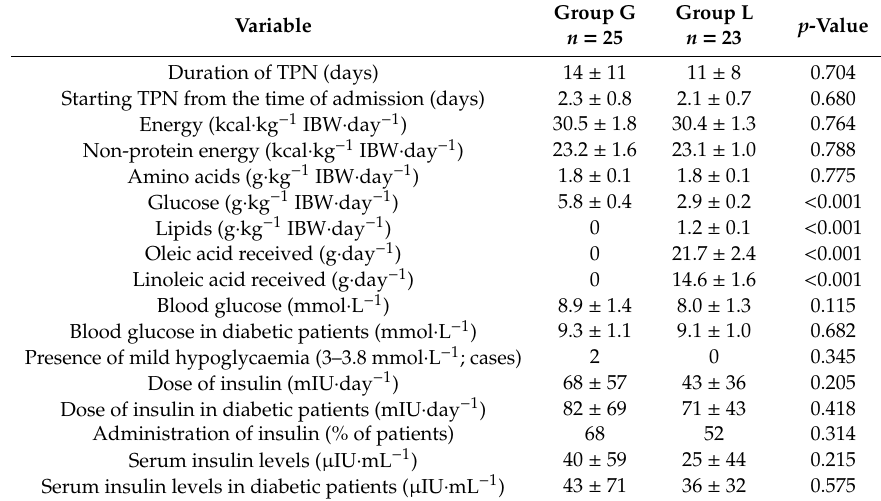
Table 3. Nutritional intake and glycaemic control throughout the course of total parenteral nutrition (mean values with standard